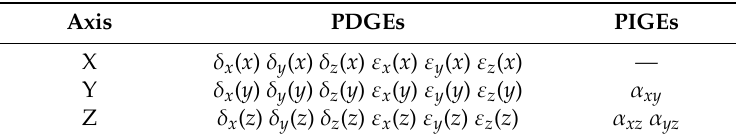
Table 1. The 21 geometric error sources of the 3-axis MTs.